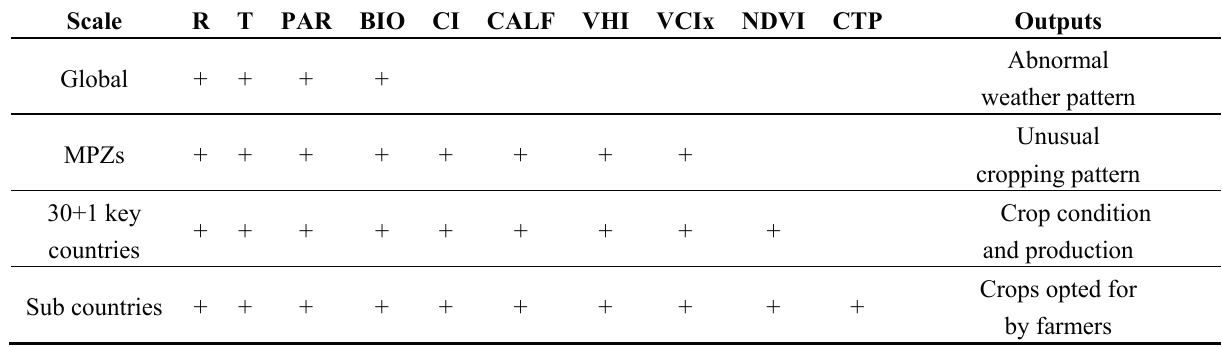
Table 1. Hierarchical indicators of CropWatch. For each scale of analysis, all the indicators of the row above are also produced. (R = CWAI for rainfall; T = CWAI for air temperature; PAR = CWAI for photosynthetically active radiation; BIO = agroclimatic biomass production potential; CI = Cropping intensity; CALF = Cropped arable land fraction; VHI = Vegetation health index; VCIx = Maximum vegetation condition index; CTP = Crop type